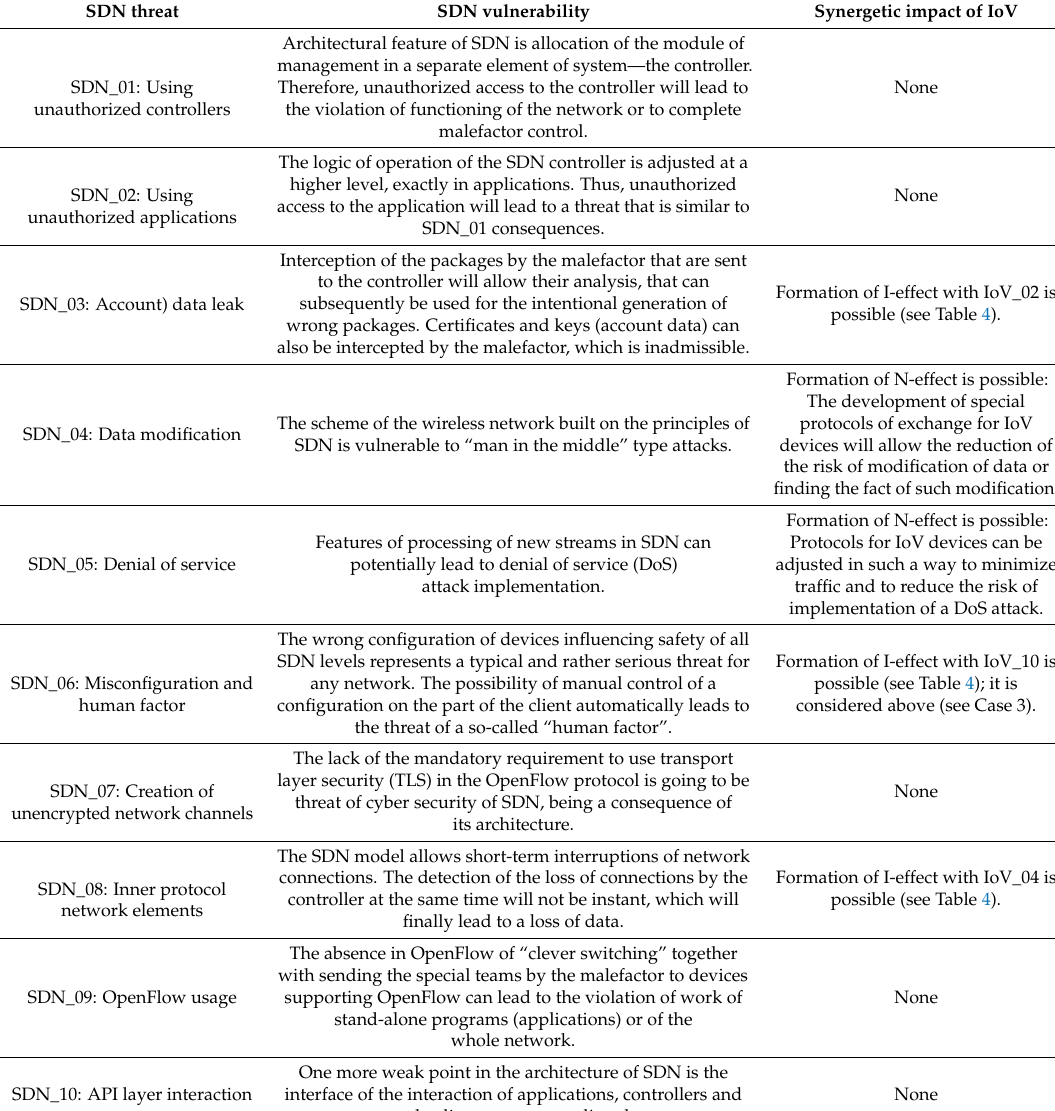
Table 3. Results of synergetic impact of the internet of vehicles (IoV) on the vulnerabilities of software defined networking